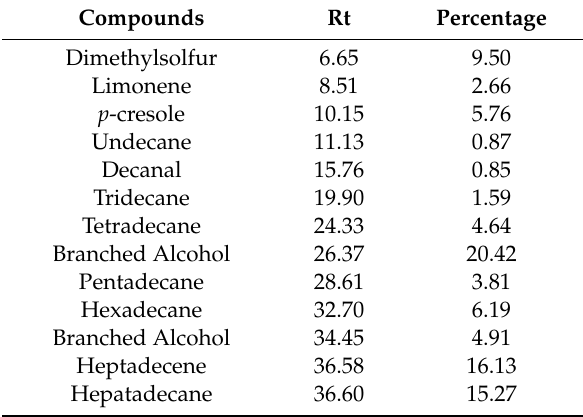
Table 5. Percentage composition and retention time in the bioglea SPME analysis.